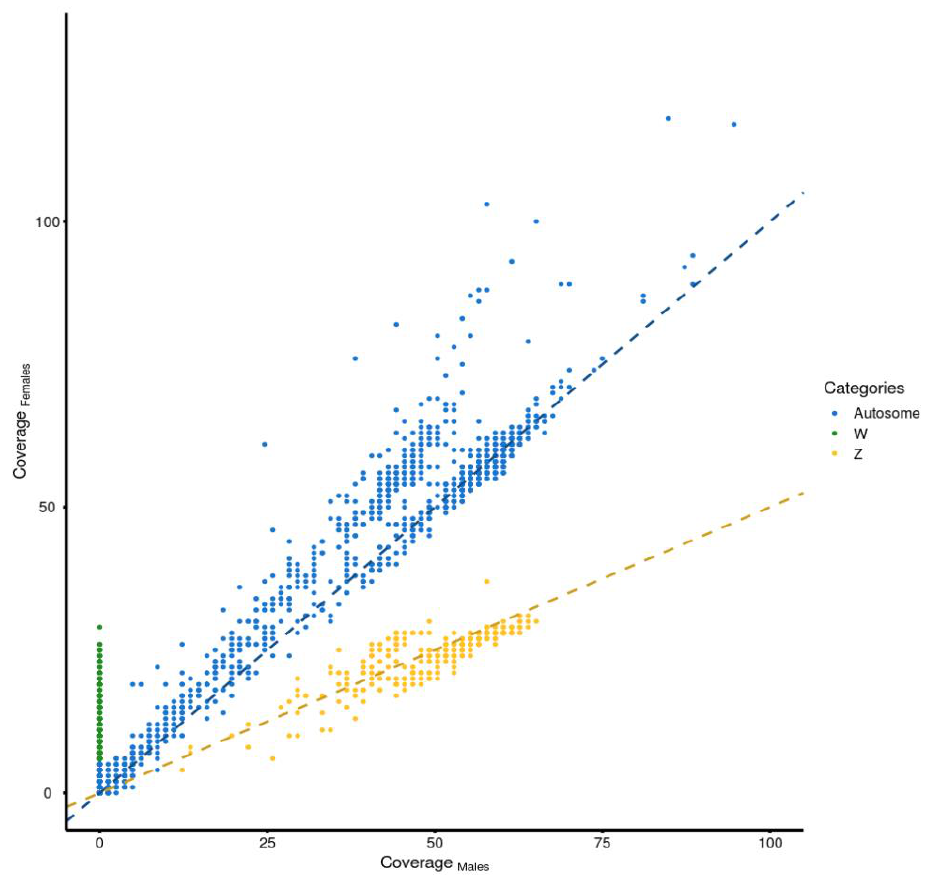
Figure 2. Identification of Z and W scaffolds using coverages of male and female individuals. Normalized sum of median per-site coverage of trimmed reads over the five males (x-axis) and seven females (y-axis). Values were only calculated for scaffolds longer than 10-Kb. Linear regressions for slope=1 (blue) and slope=0.5 (yellow) are shown. Scaffolds were assigned following the decision rule described in the material and methods